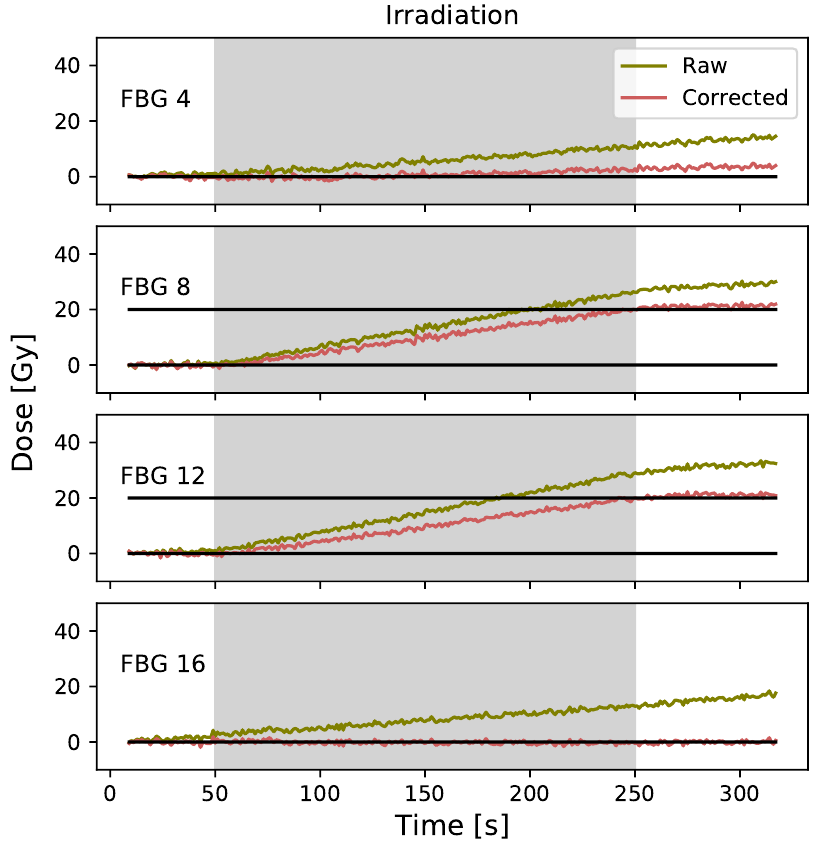
Figure 5. Raw and corrected data were obtained using the PPD technique. FBG #4 and #16 are located outside the irradiation field and the FBG #8 and #12 are located inside the field. It should be noted that here that only 50 s of pre-irradiation are plotted to allow easier comparison with the next technique, but the correction was generated over the 60 s of pre-irradiation